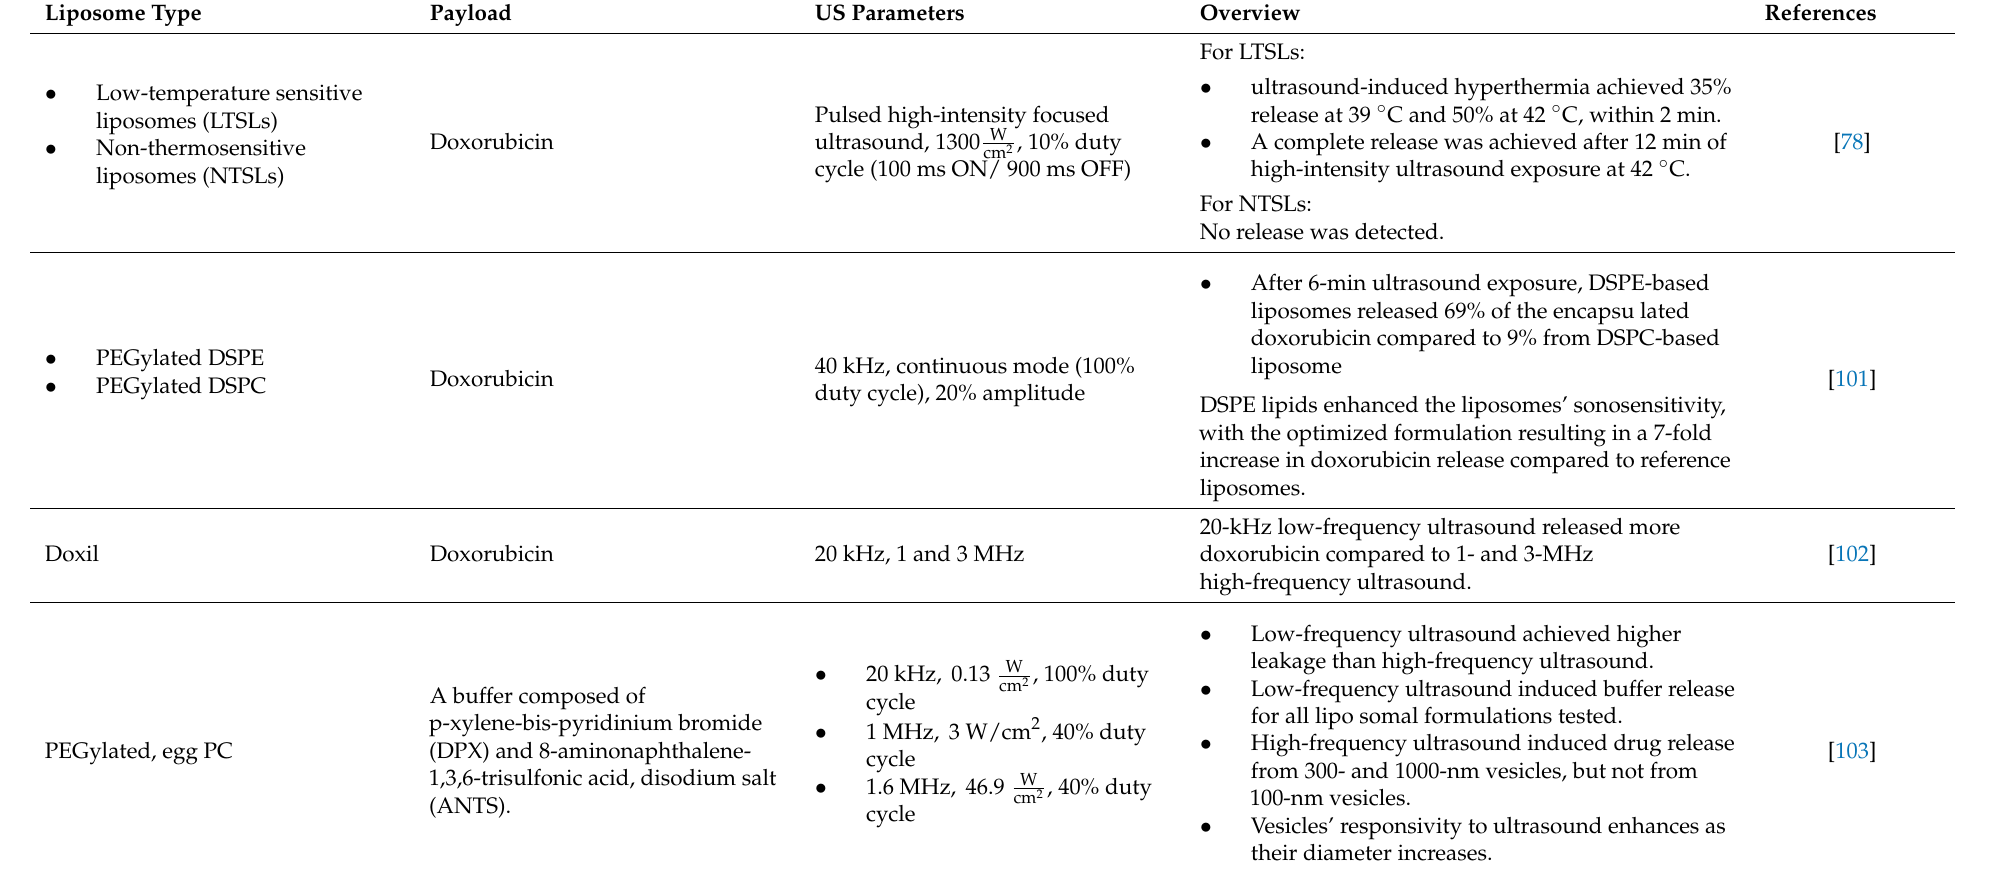
Table 3. In vitro release experiments of nanodrugs from liposomes using